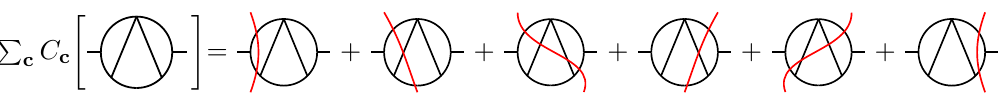
Figure 3. The sum over all Cutkosky cuts of a forward-scattering diagram is IR-finite.